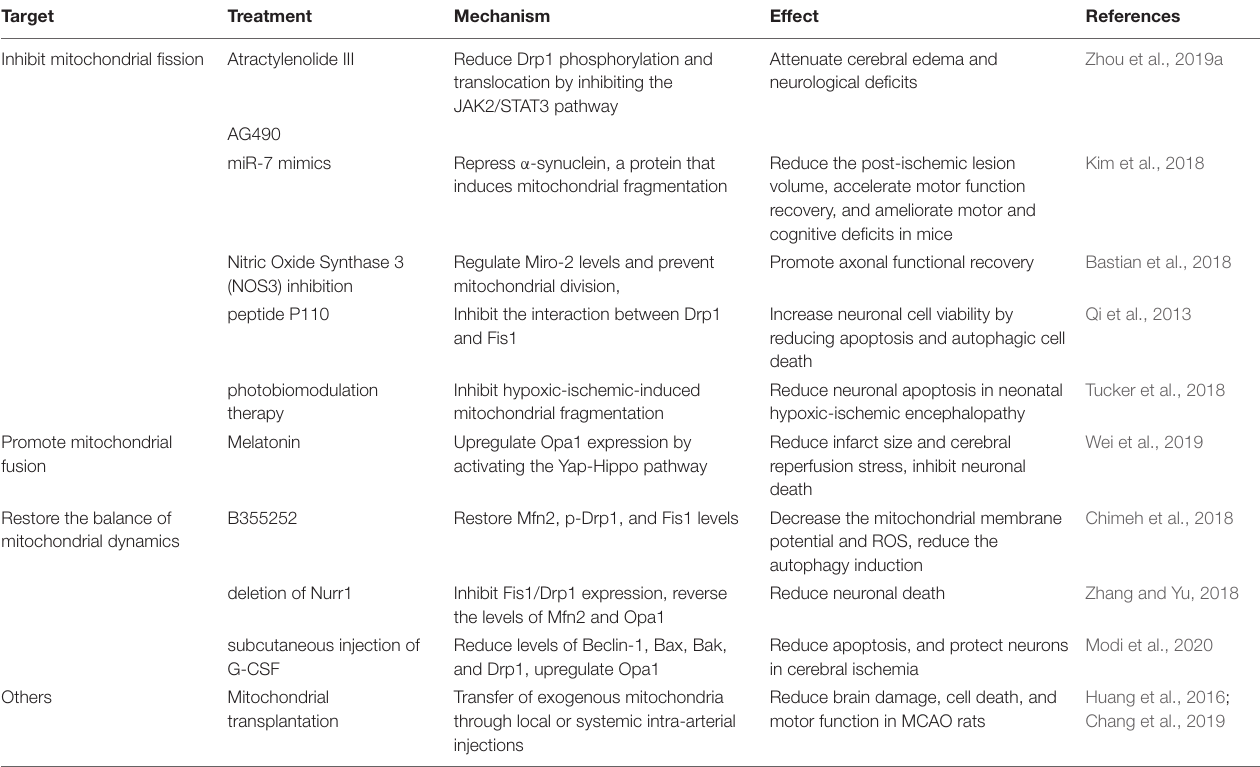
TABLE 2 | Drugs targeting mitochondrial dynamics after ischemic